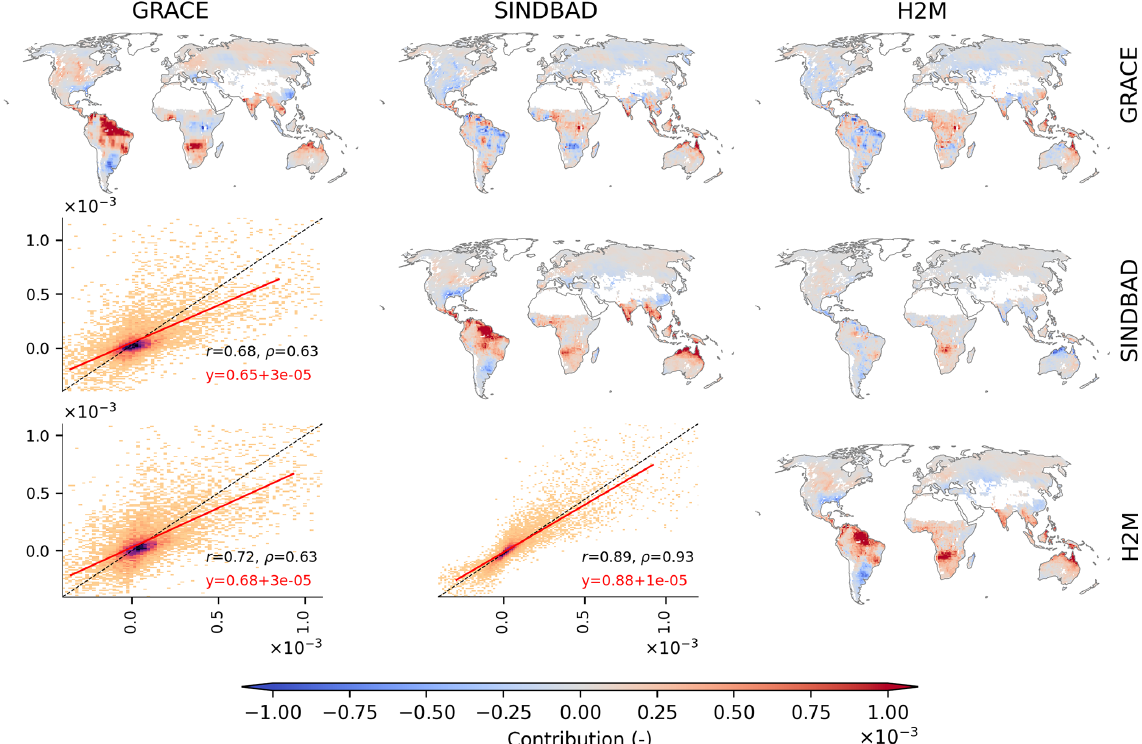
Figure 3. Global distribution of pixel-wise contributions to the variance in the global terrestrial water storage (TWS) IAV. Along the diagonal, maps of the pixel-wise contribution in GRACE, SINDBAD, and H2M are shown (indicated by the label of the row or column). Above the diagonal, maps of the difference (i.e., column − row) are shown. For example, the map of the first row and the second column is for SINDBAD (column) minus GRACE (row). Below the diagonal, scatterplots comparing the pixel-wise contributions of the corresponding column ( x axis) versus row ( y axis) are shown. In the scatterplots, colors indicate the density of point, r is the Pearson correlation coefficient, and ρ is the Spearman correlation coefficient. Red lines are the linear regression fit, and red text refers to the corresponding equations. White pixels within land boundaries are the regions masked out in this study (see Appendix